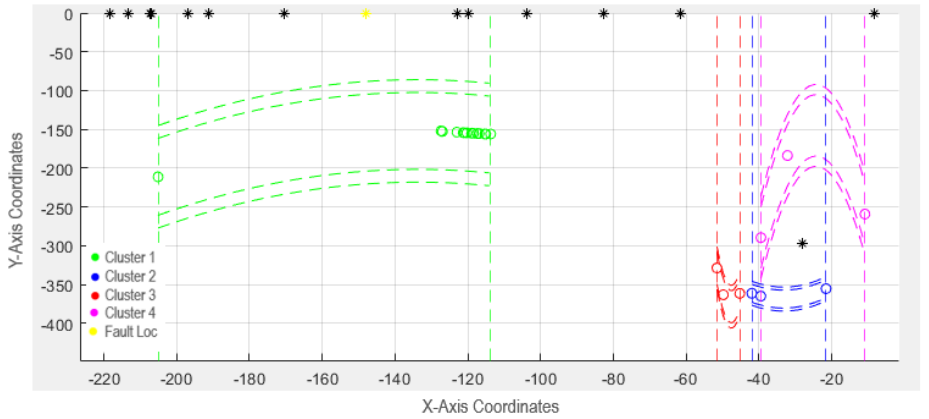
Figure 22. 1000 Ω fault identified.